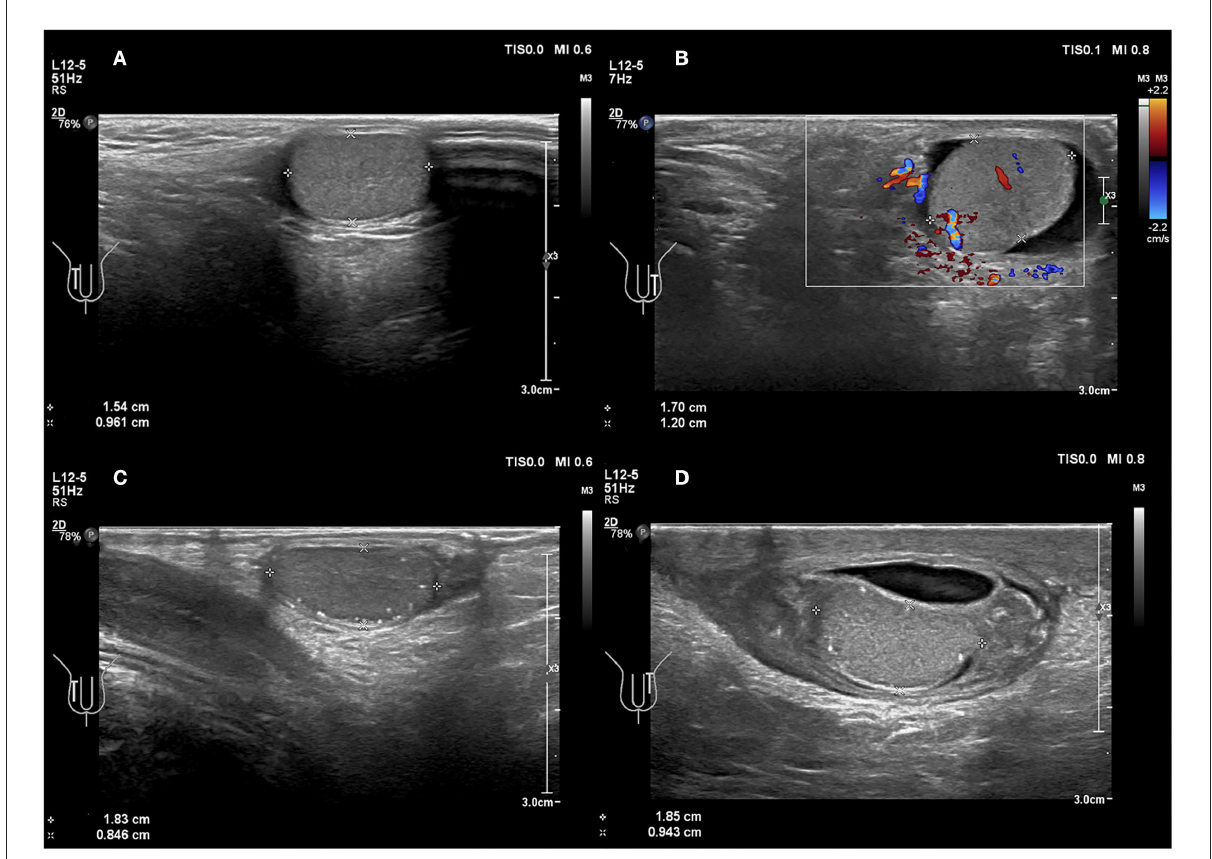
FIGURE3 (A,B) A 6 years 4-month-old boy with a first episode of acute left scrotal pain for 2 days. (A) Normal testicle, no change in testicular axial direction. (B) Torsion of the testicle and the testicle change in axial direction. (C,D) An 8 years 3-month-old boy with the third episode of